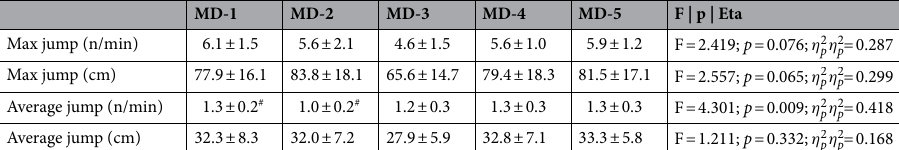
Table 3. Descriptive statistics (mean ± standard deviation) of the overall group’s jump outcomes while organizing each day of the